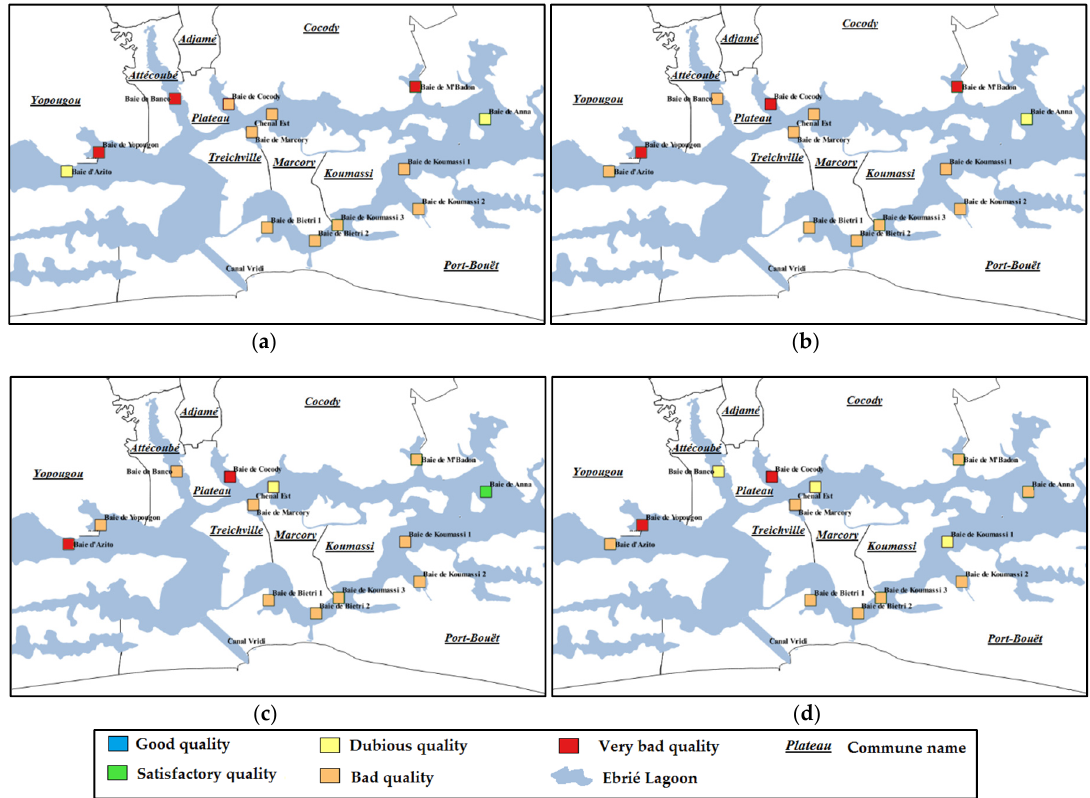
Figure 6. Spatio ‐ temporal variation of the Water Quality Index for livestock watering: ( a ) June 2014, ( b ) June 2015, ( c ) December 2014, and ( d ) December 2015.